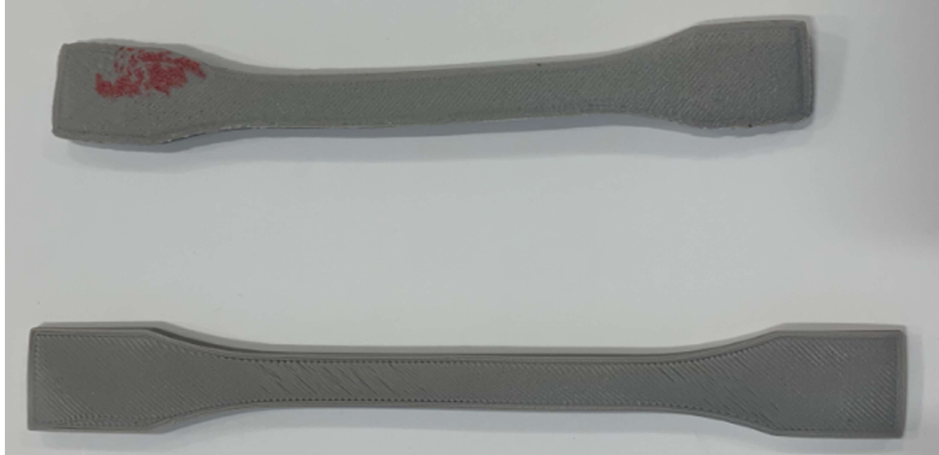
Figure 8. Significant deformation of Al-ASA at high annealing temperatures.